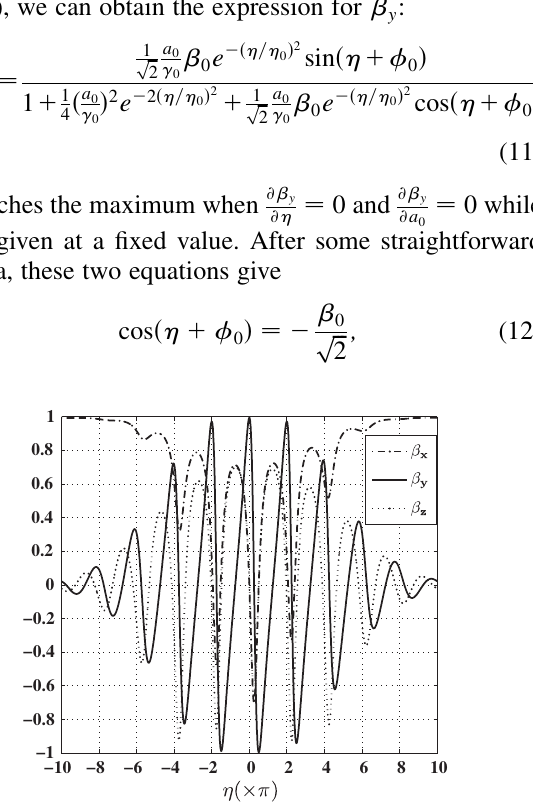
FIG. 6. The normalized velocity of the electron as a function of (cid:1) in a circularly polarized laser field. (cid:8) projections of (cid:1) on each of the coordinate axes. All of the calculation parameters are the same as those in Fig. 2.